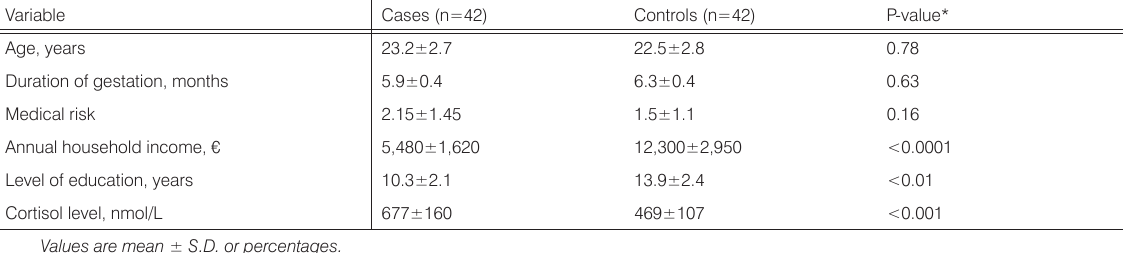
Table 1. Key characteristics of two groups of pregnant women with normal and altered resistance to maternal stress